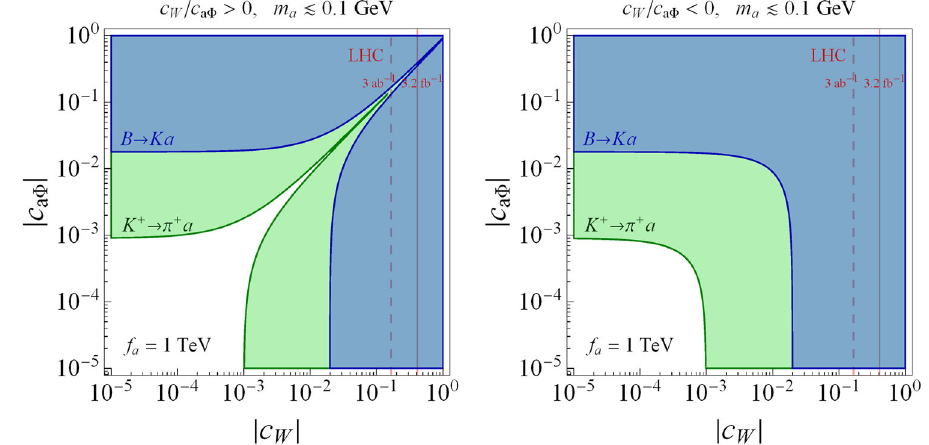
Fig. 3 Allowed { c W , c a (cid:7) } parameterspace for theinvisible ALP when those two couplings are simultaneously present. The superposition of the constraints from K + → π + + inv (green) and B + → K + + inv (blue) data is shown for an illustrative case with f a = 1 TeV and